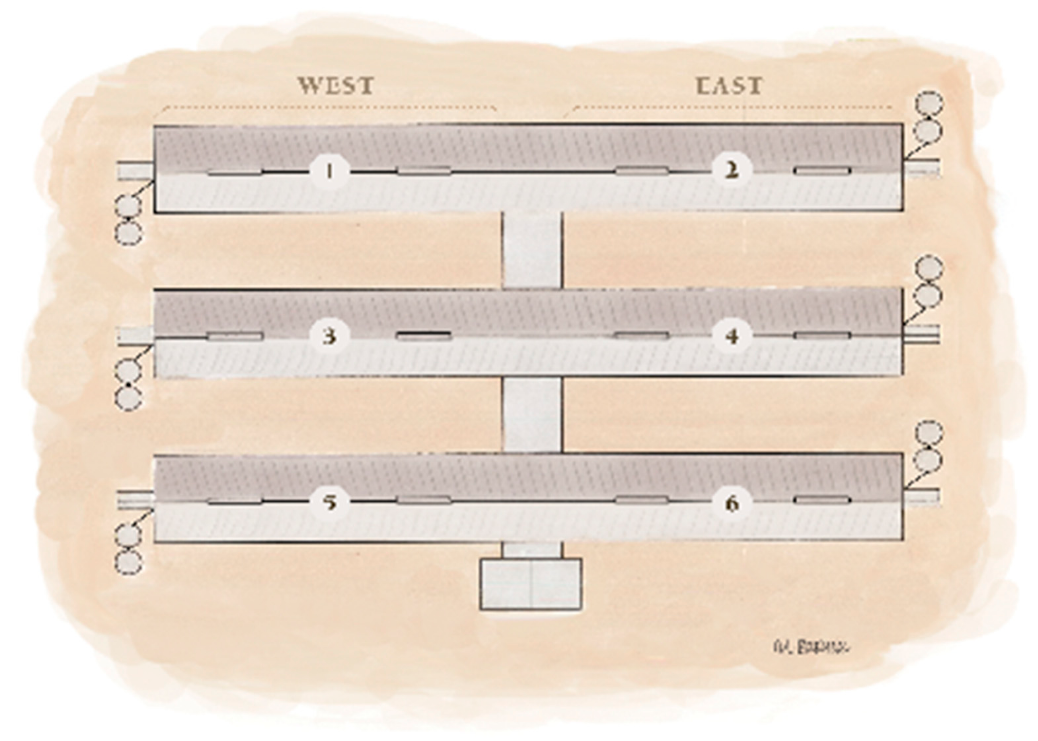
Figure 2. Configuration of a wean-to-finish site characteristic of this study: six barns per site, three on each side of a central hallway and numbered as shown. The central hallway connected all six barns. Feed bins were located at the end of each barn. Table 1. Square footage for each barn configuration, including area allotted per pen.